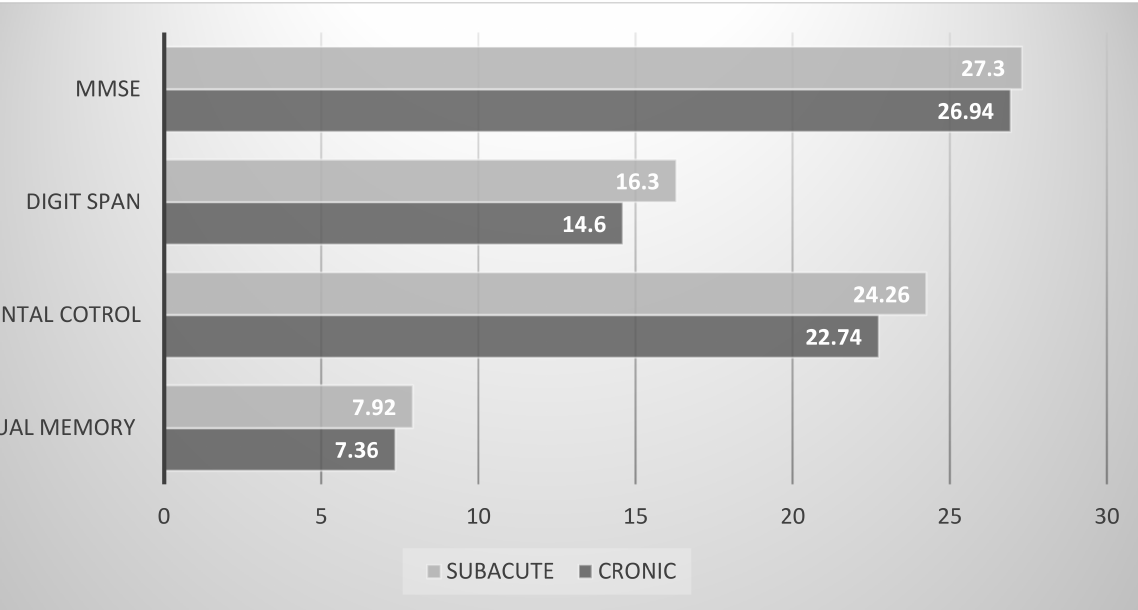
Figure 2. MMSE, digit span (WMS-III), mental control (WMS-III), and visual memory (Barcelona test) scores in SCI patients. Legend: MMSE: mini-mental State Examination; digit span (WMS-III): digit span subtest of the Wechsler memory scale; mental control (WMS-III): mental control subtest of the Wechsler memory scale; BT: Barcelona